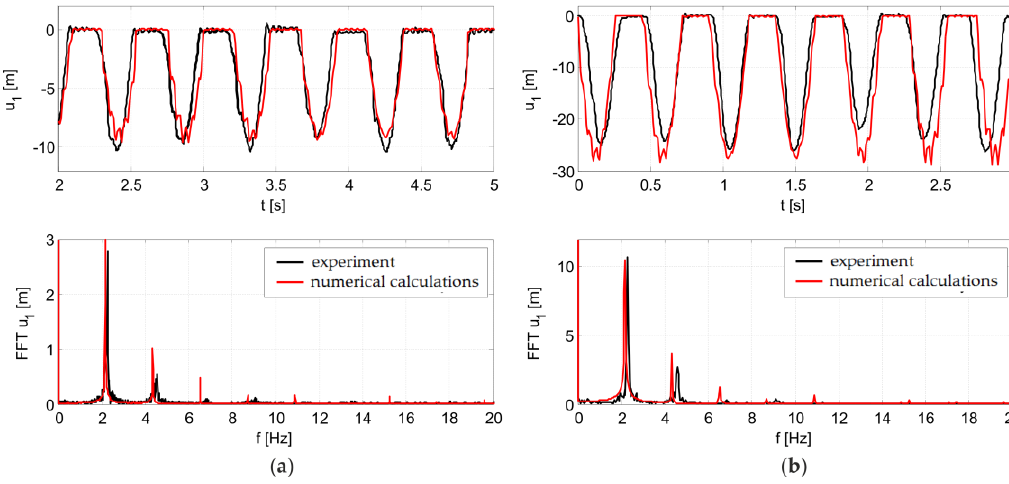
Figure 16. Numerical model validation results for jumps performed by: ( a ) one person, ( b ) three people .